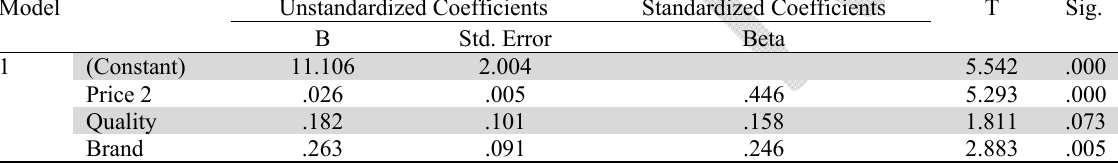
Model 5 Multiple Linear Regression Test Results (Coefficients a )